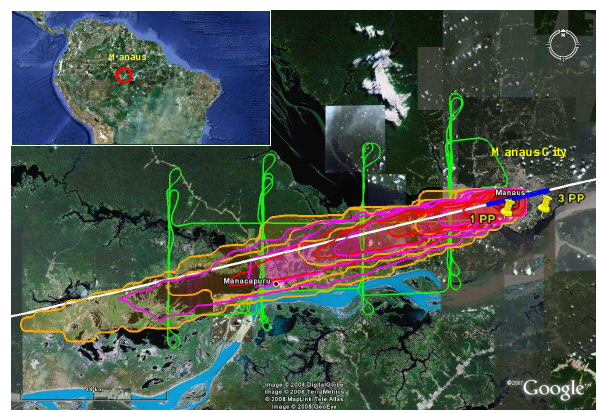
Fig. 1. Land cover image (GOOGLE EARTH) with an overlay of the flight pattern of Flight #18 on 19 July 2001 at 10.00–14:00LT (GPS data, green line), the path of the SCM model (white line, the blue colour indicates where surface characteristics in the SCM are changed to city conditions), and the output of a HYSPLIT disper- sion model run indicated by the red/orange contour lines (based on meteorological REANALYSIS dataset for the time of the flight period, i.e., start time in Manaus City ( − 3.08 ◦ , − 60.01 ◦ ) was 10:00LT, with 4h total run time in the 0–1500m level). The 2 yel- low pins within Manaus City indicate the areas where power plants are located (3PP with > 560MW in the southeast, and 1PP with > 125MW in the southwest of the city). The overview map shows the location of Manaus within the Amazon rain forest (South Amer-